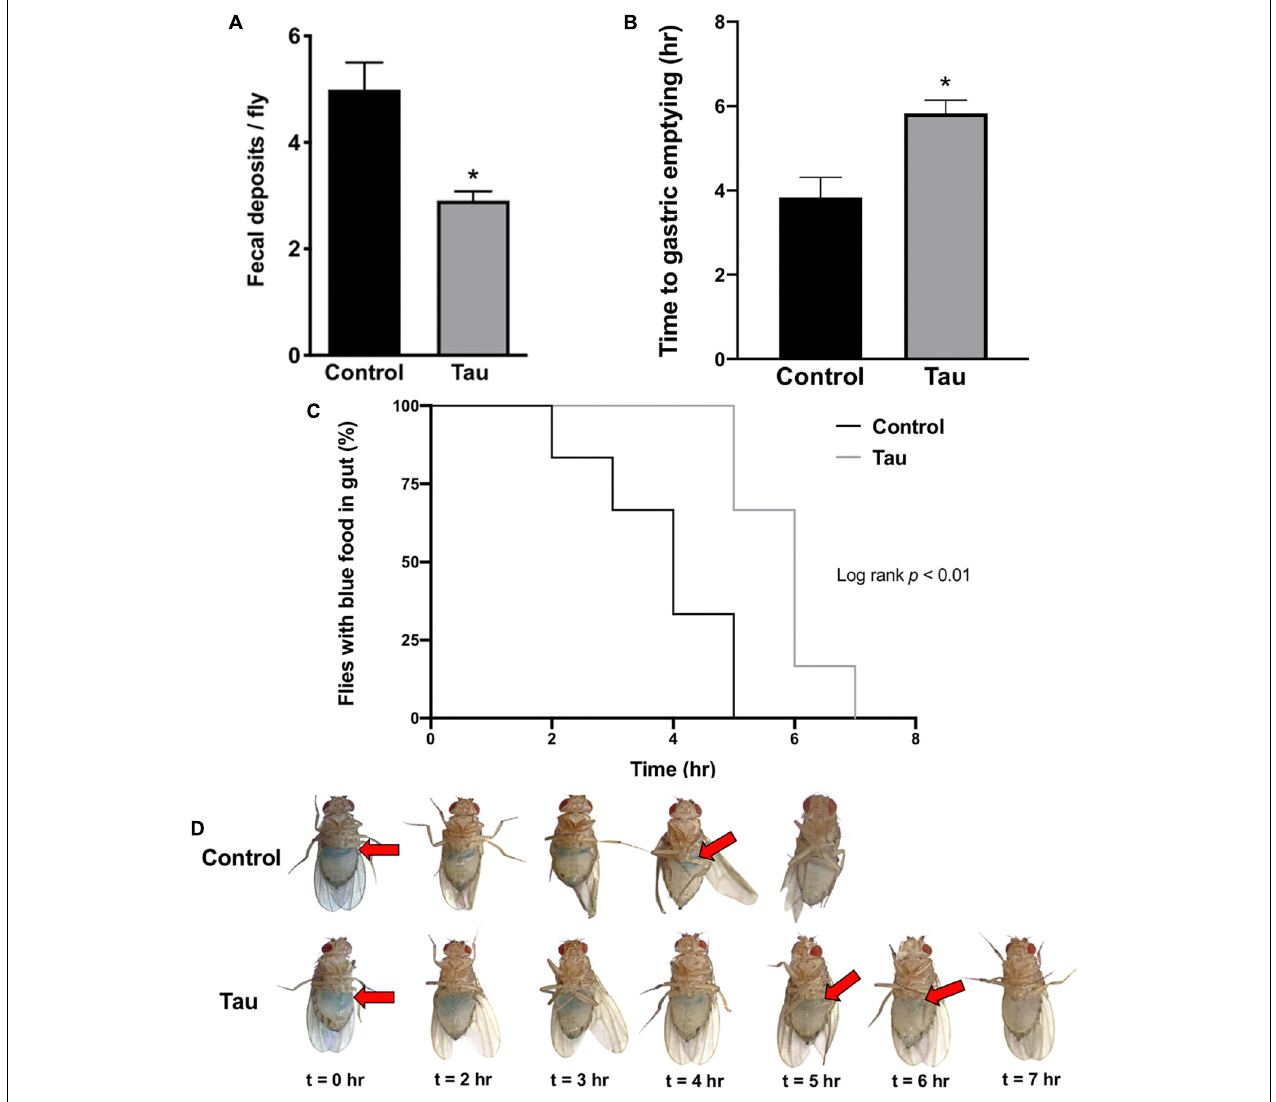
FIGURE 1 | Neuronal tau expression reduces Drosophila gut motility. (A) Tau transgenic flies show reduced fecal deposits per fly ( n = 5–7, t -test * p < 0.05). (B–D) Tau transgenic flies demonstrate an increased time to gastric emptying (B) ( n = 6, t -test * p < 0.05), supported by the prolonged presence of blue food in the abdomen in a gastric emptying time course (C,D) . Data are shown as average ±